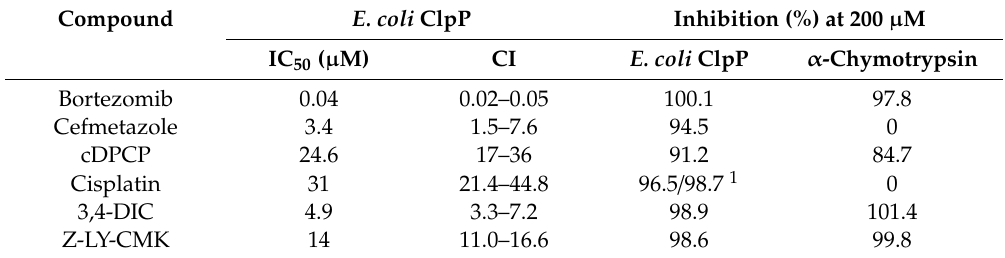
96 Figure 1. Structural formula of the five ClpP inhibitors identified in this study. Table 1. Overview of IC 50 values of identified ClpP inhibitors and the positive control (Z-LY-CMK), confidence interval (CI) as well as inhibition of E. coli ClpP and bovine α-chymotrypsin at 200 μM compound concentration.